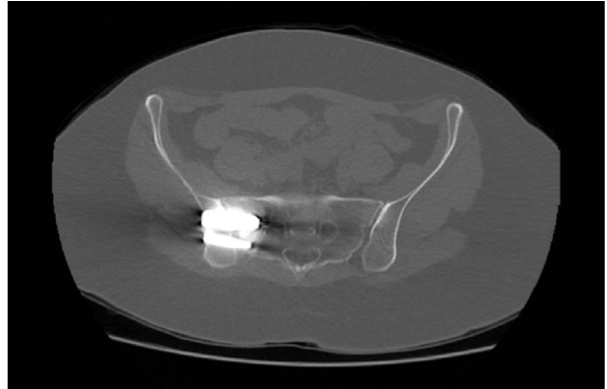
Figure 3. Axial cuts of a CT scan of pelvis, showing sacral osteolysis around caudal implants on the left